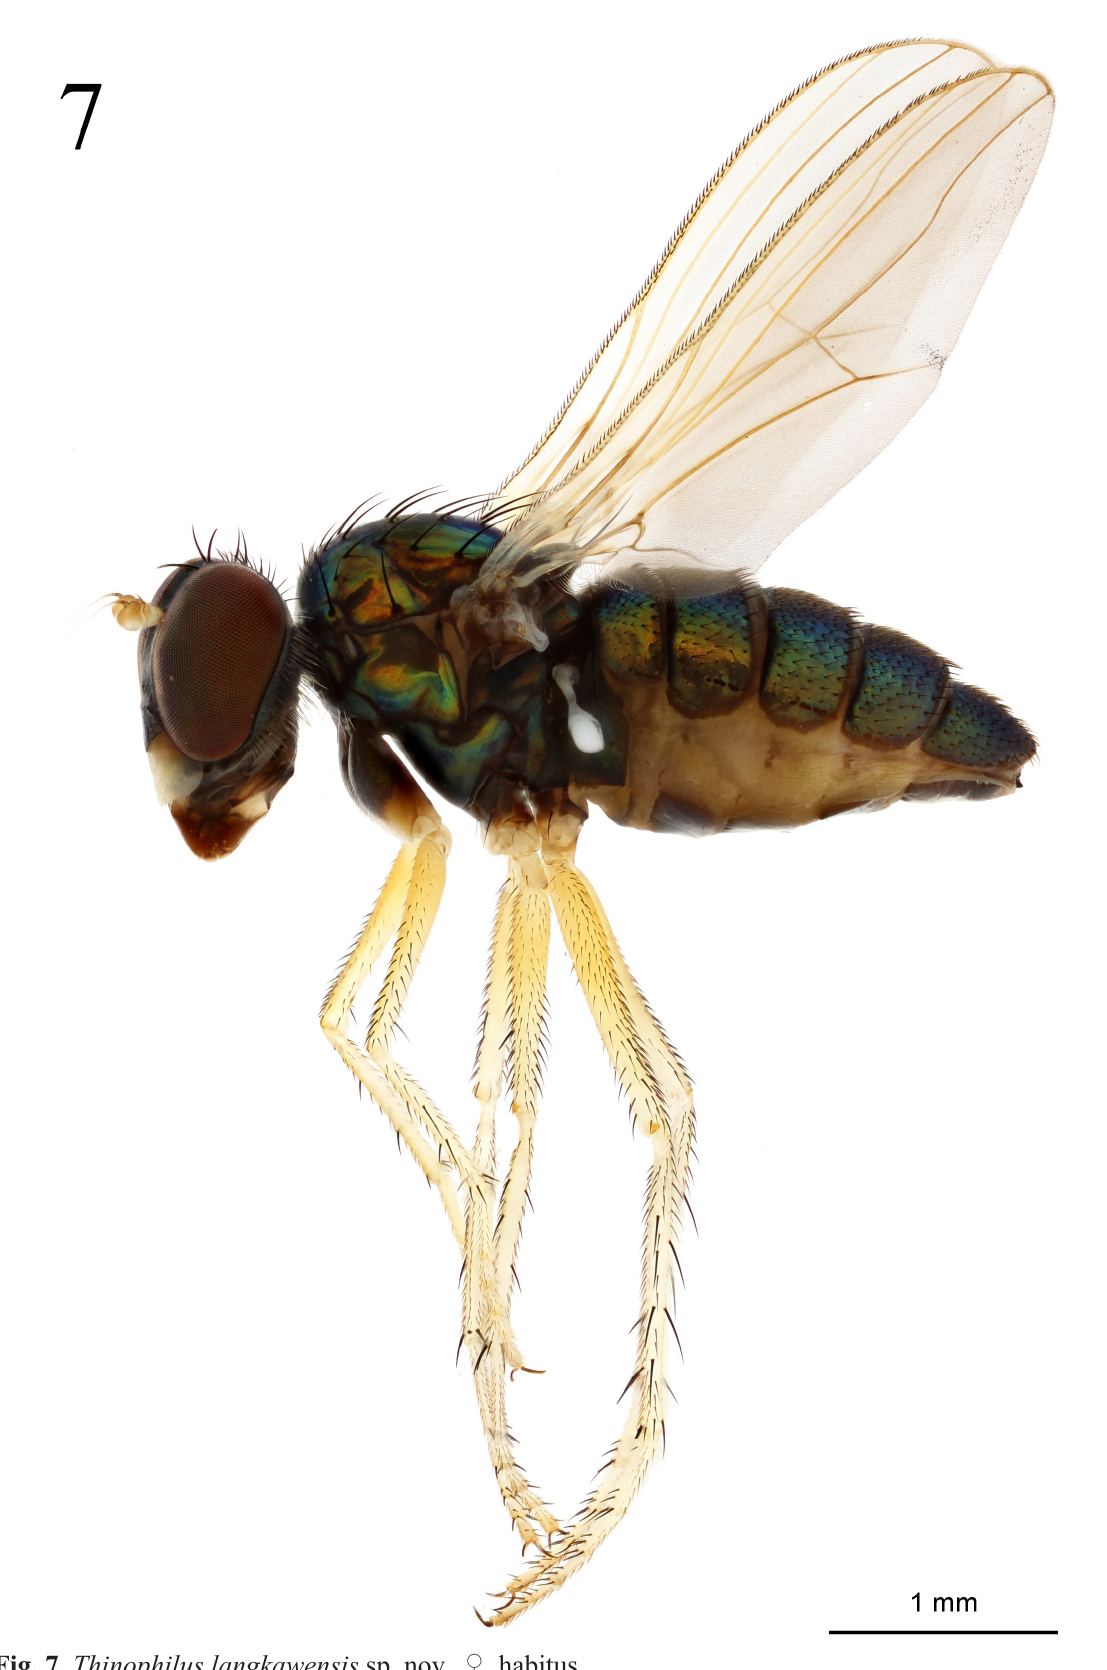
Fig. 7. Thinophilus langkawensis sp. nov., ♀,